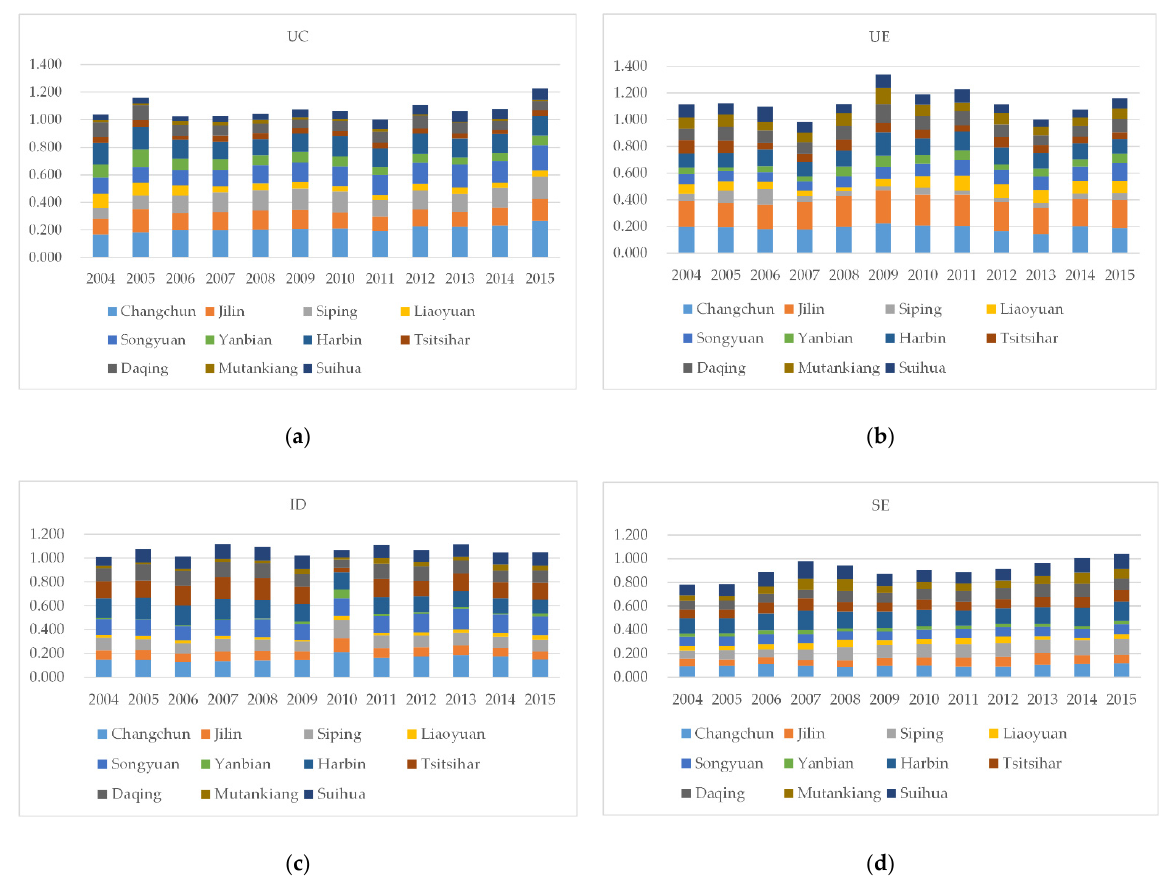
Figure 6. The LCCC of each subsystem of the cities in the HCUA. ( a – d ) are the LCCC of UC, UE, ID, and SE, respectively, during 2004–2015.